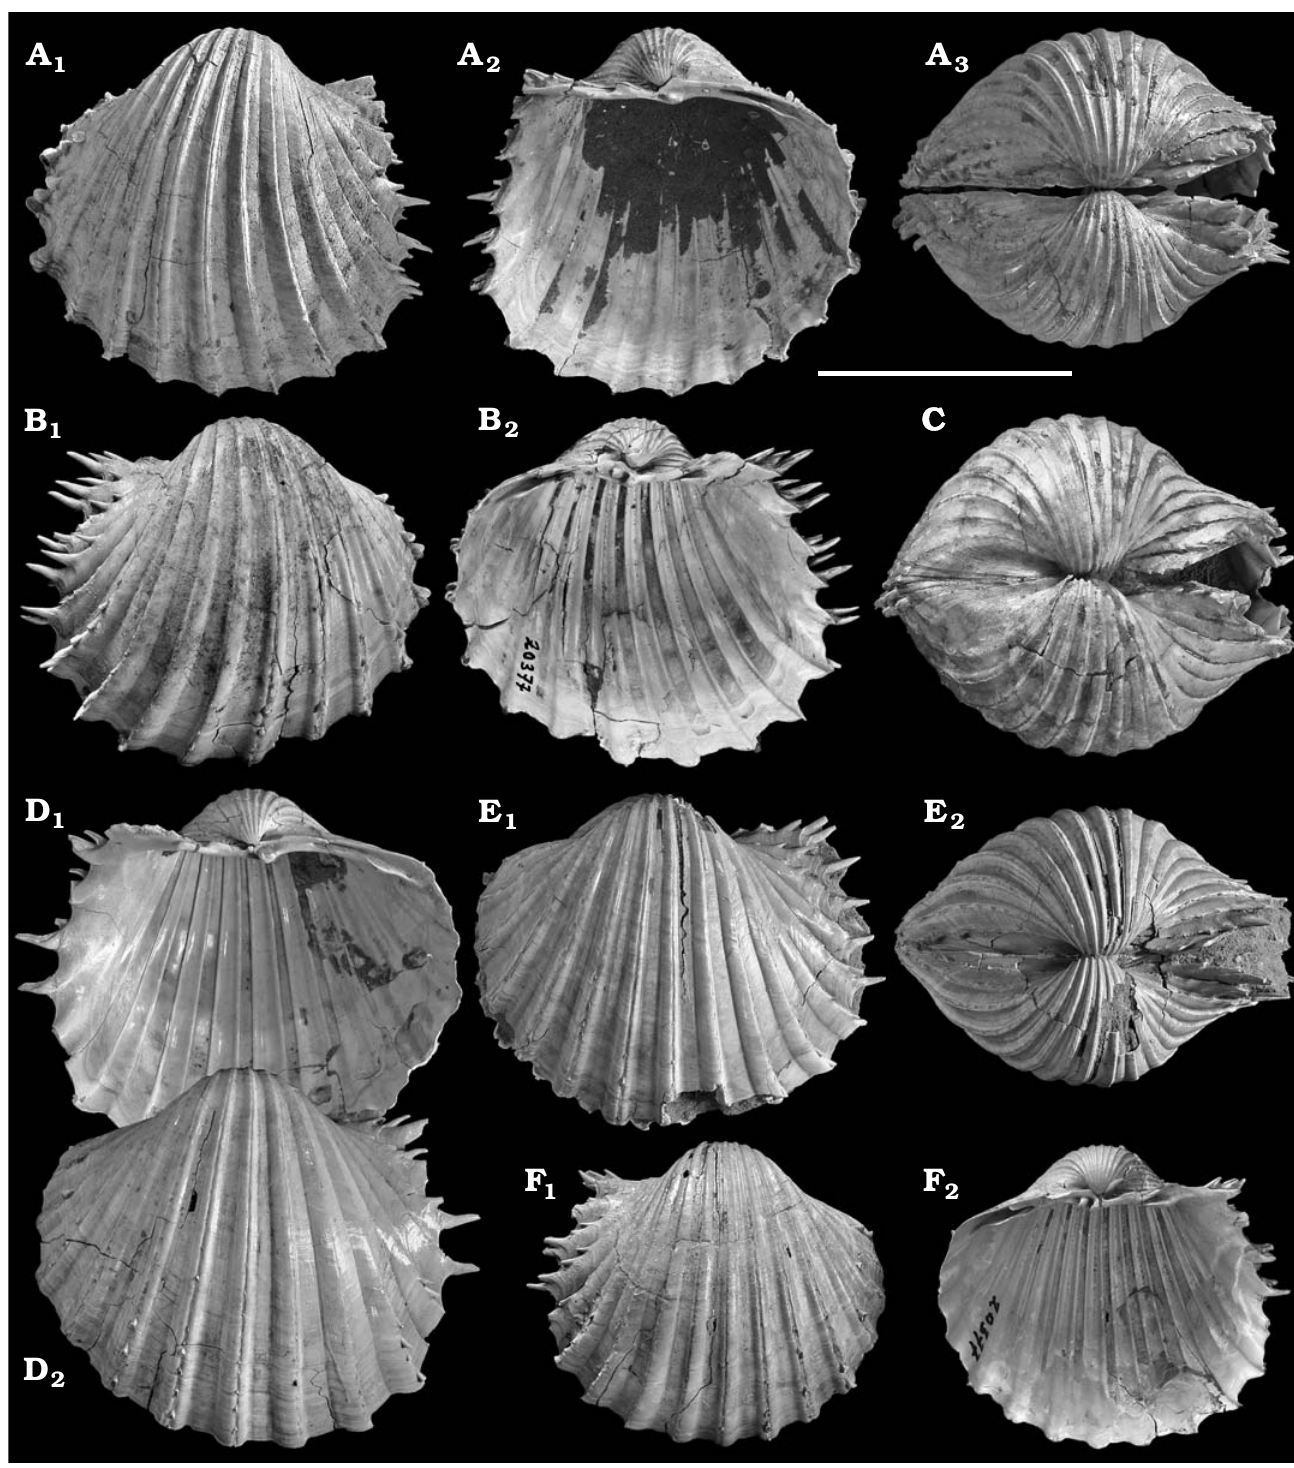
Fig. 5. Cardiid bivalve Procardium avisanense (Fontannes, 1879) from Tortonian (Miocene) of Portugal, Cacela Velha (A, D, E) and Fabrica (B, C, F). A . RGM.794106.a (van Nieulande collection), internal (A 1 ), external (A 2 ), and umbonal (A 3 ) views. B . PH 20377, internal (B 1 ) and external (B 2 ) views. C . PH 20377, umbonal view. D . RGM.794104.a, internal (D 1 ) and external (D 2 ) views. E . RGM.794104.b, external (E 1 ) and umbonal (E 2 ) views. F . PH 20377, external (F 1 ) and internal (F 2 ) views. Scale bar 50